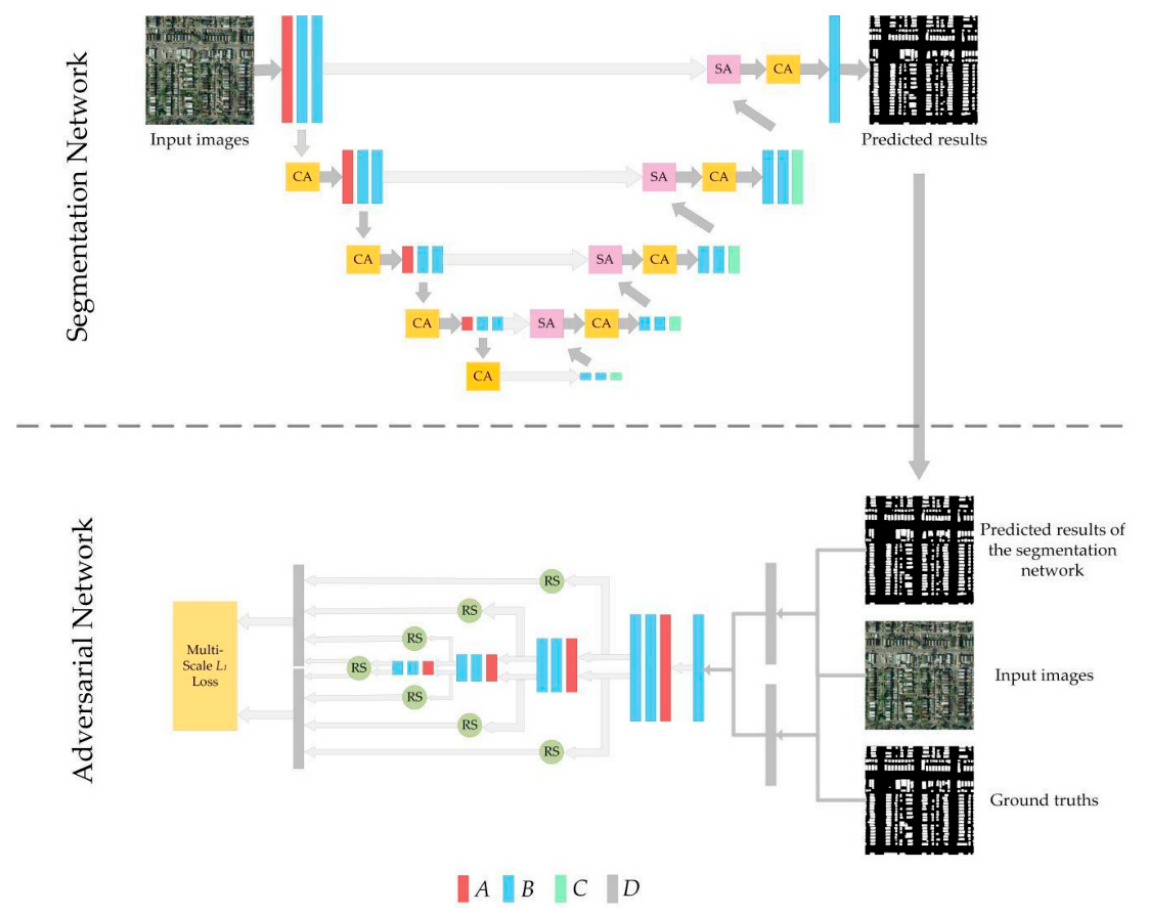
Figure 4. An example of adding spatial and channel attentions to a GAN module for building detection from aerial images [75]. A—max pooling layer; B—convolutional + batch normalization + rectified linear unit (ReLU) layers; C—upsampling layer; D—concatenation operation; SA—spatial attention mechanism; CA—channel attention mechanism; RS—reshape operation.